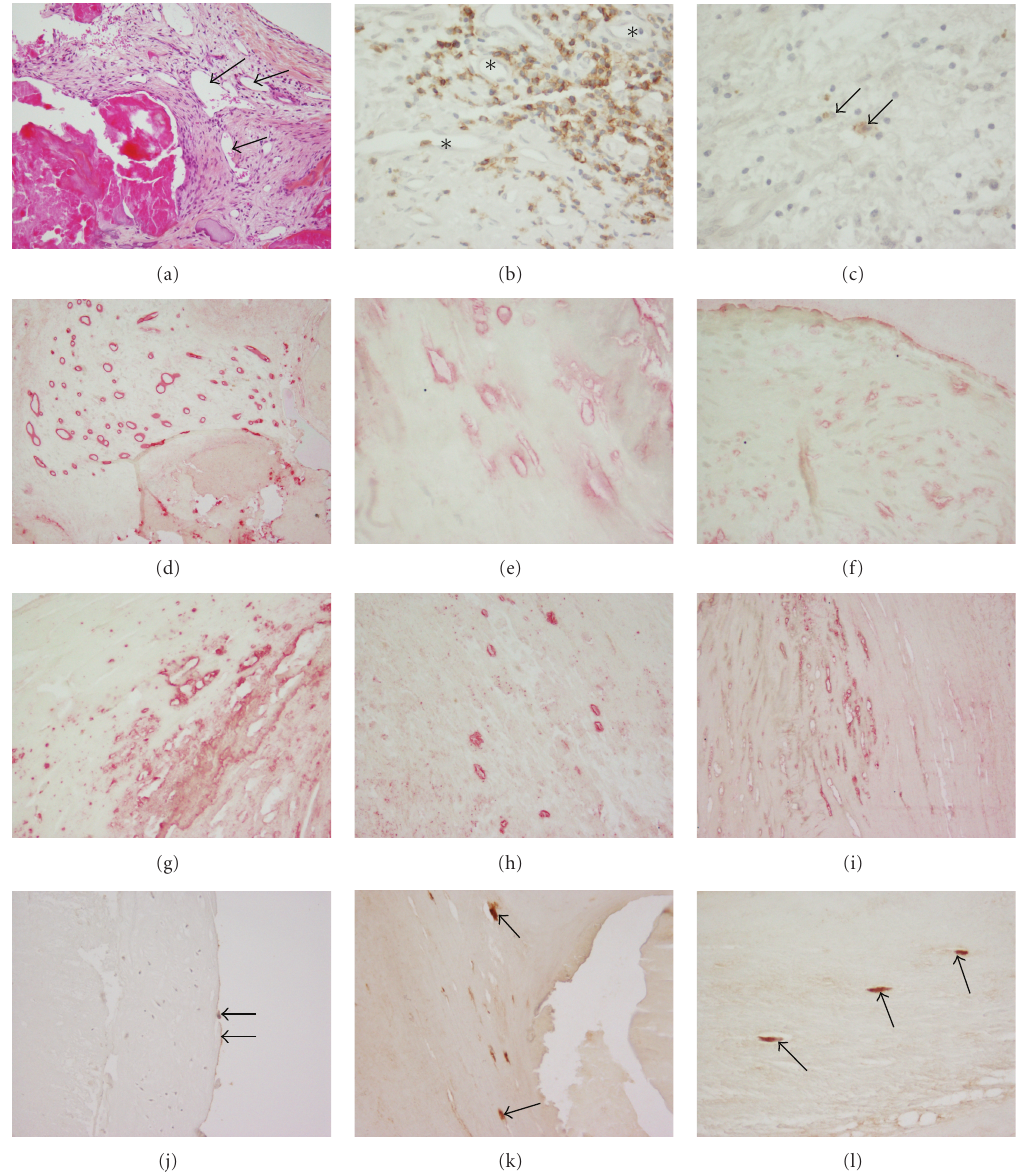
Figure 1: Immunohistochemical pattern of inflammatory infiltrate and neovascular endothelial cells in microscopically calcified (ECC) and noncalcified (ECN) areas, as well as of surface endothelial cells (ECS) in aortic valves from patients with calcific aortic stenosis. (a) Hematoxylin-Eosin-Sa ff ron staining, note multiple capillary neovessels near calcified area (arrows); (b) CD3+ lymphocytes in the range of neovessels (asterisks) near calcific lesions; (c) CD117+ cells corresponding to mast cells are sparsely present. (d) Neovessels of all subgroups are highlightened by FVIII staining (here: ECC) (e) CXCL12 (ECC); (f) CXCL12 (ECN); (g) CXCR4 (ECC); (h) CXCR4 (ECN); (i) IL- 6 (ECC); (j) VEGF in surface endothelial cells (arrows on ECS); (k) VEGFR (arrows on ECC); (l) VEGFR (arrows on ECN). Images (a),(d),(f),(g),(h),(i),(j),and (k): magnification × 100; images (b),(c),(e), and (l): magnification ×